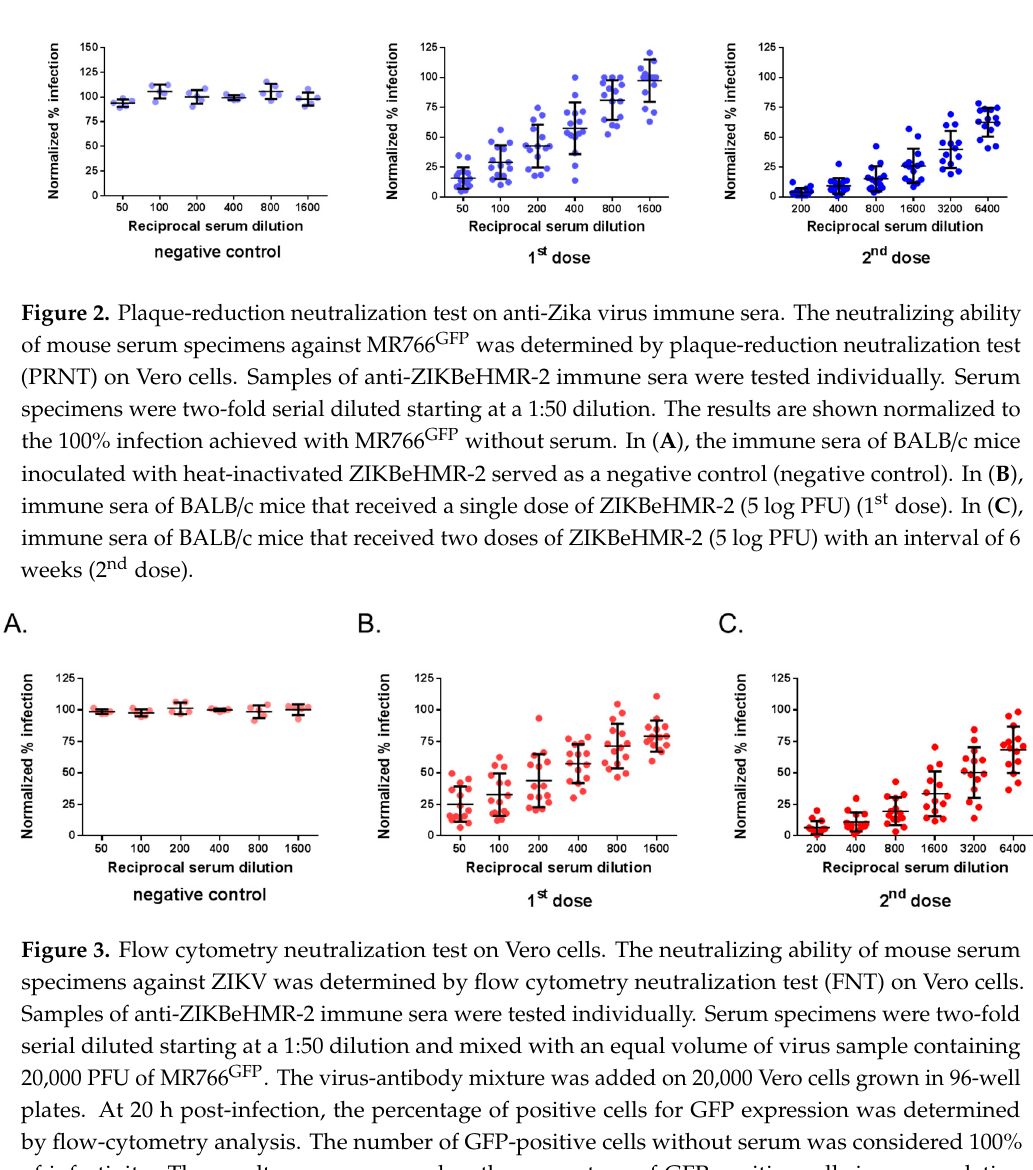
Figure 2. Plaque-reduction neutralization test on anti-Zika virus immune sera. The neutralizing ability of mouse serum specimens against MR766 GFP was determined by plaque-reduction neutralization test (PRNT) on Vero cells. Samples of anti-ZIKBeHMR-2 immune sera were tested individually. Serum specimens were two-fold serial diluted starting at a 1:50 dilution. The results are shown normalized to the 100% infection achieved with MR766 GFP without serum. In ( A ), the immune sera of BALB/c mice inoculated with heat-inactivated ZIKBeHMR-2 served as a negative control (negative control). In ( B ), immune sera of BALB/c mice that received a single dose of ZIKBeHMR-2 (5 log PFU) (1 st dose). In ( C ), immune sera of BALB/c mice that received two doses of ZIKBeHMR-2 (5 log PFU) with an interval of 6 weeks (2 nd dose).